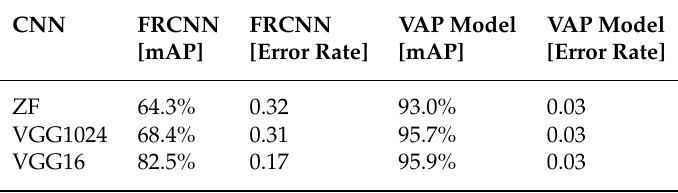
Table 1. Performance comparison between the faster RCNN and the VAP